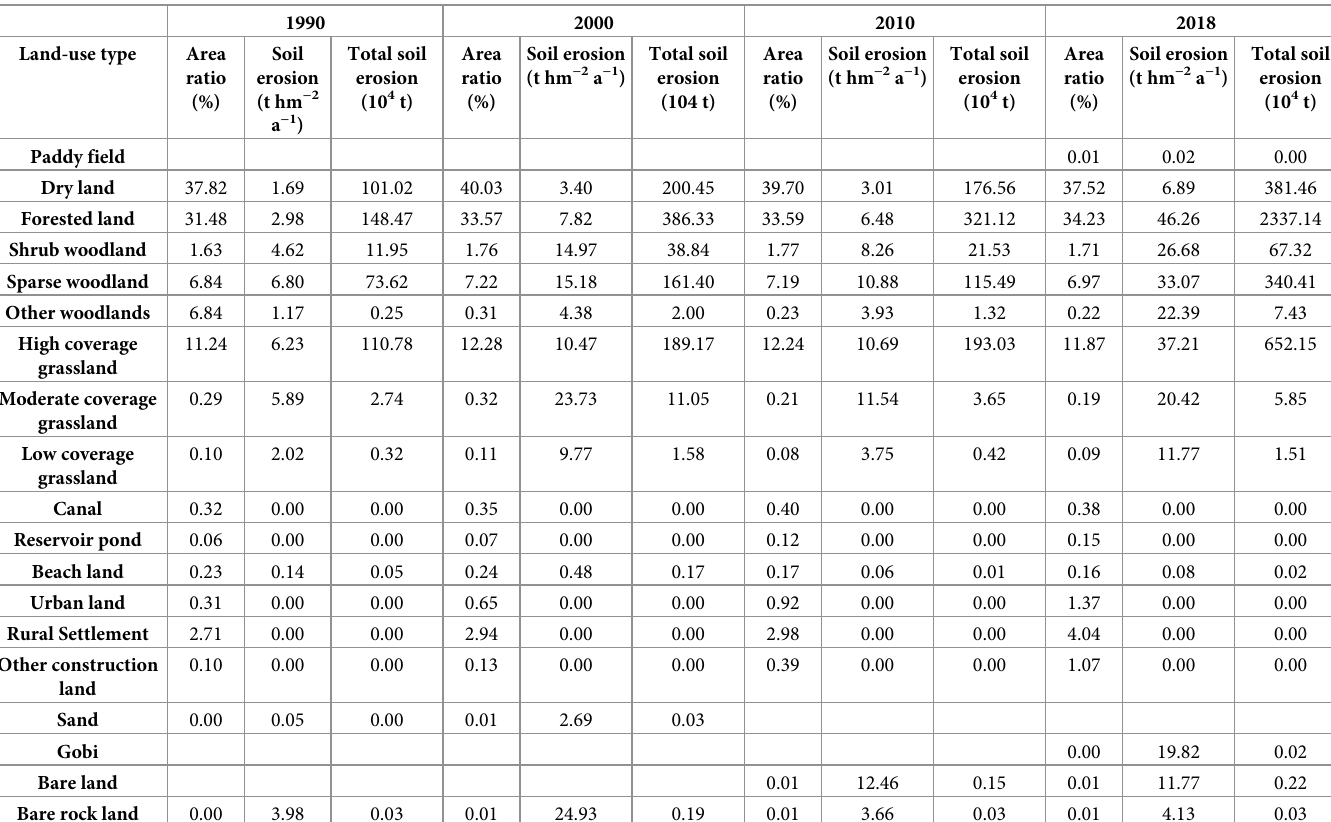
Table 4. Spatiotemporal changes in soil erosion for land-use patterns from 1990 to 2018.